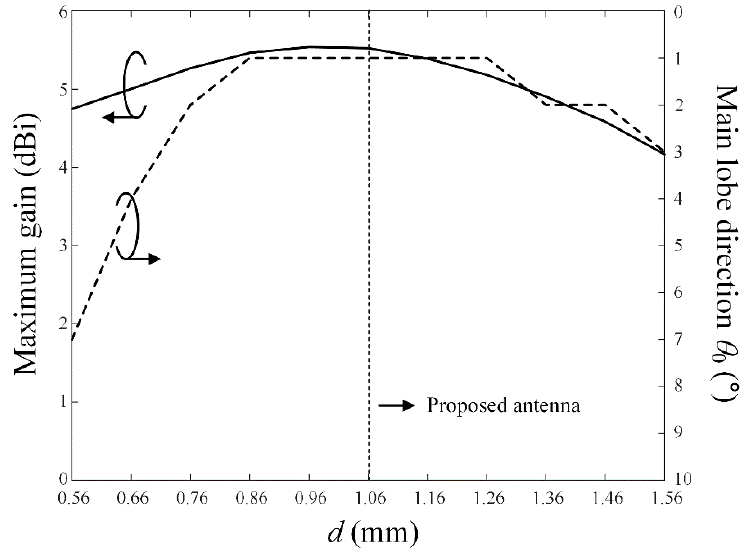
Figure 3. The maximum gain and main lobe direction θ 0 in accordance with the parameter d at 28 GHz.